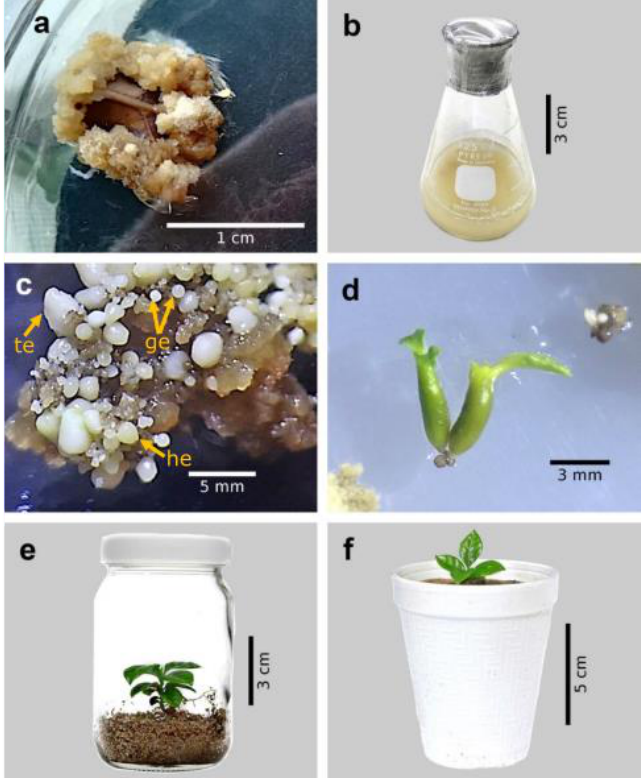
Figure 1. Somatic embryogenesis in coffee ( Coffea arabica L. var. Colombia). ( a ) Embryogenic callus from leaf explants after eight weeks. ( b ) Embryogenic callus production in liquid medium after 12 weeks. ( c ) Somatic embryos in different stages of development after 150 d of culture differentiation medium. ( d ) Cotyledonary embryos after four weeks of culture on maturation medium. ( e ) In vitro plant grown in vermiculite:perlite mixture (3:1). ( f ) In vitro regenerated plant grown under greenhouse conditions. ge: globular, he: heart, te: torpedo. Table 1. Effect of different combinations of 2,4- D and BAP at two concentrations of phytagel on induction of embryogenic callus from leaf explants of C. arabica var. Colombia after two months of culture. All cultures were kept under dark conditions at 26 ± 2 °C.